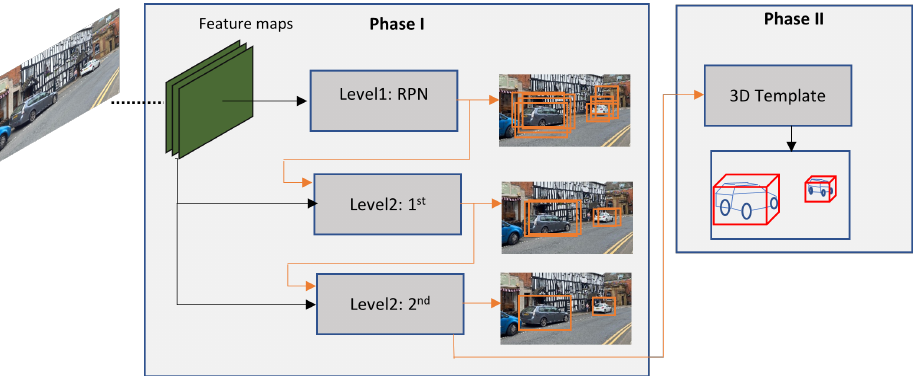
Figure 17. DeepMANTA: at phase I three level of refinements is applied; and at phase II the predicted bboxes from Phase I are used to infer 3D coordinates [100].